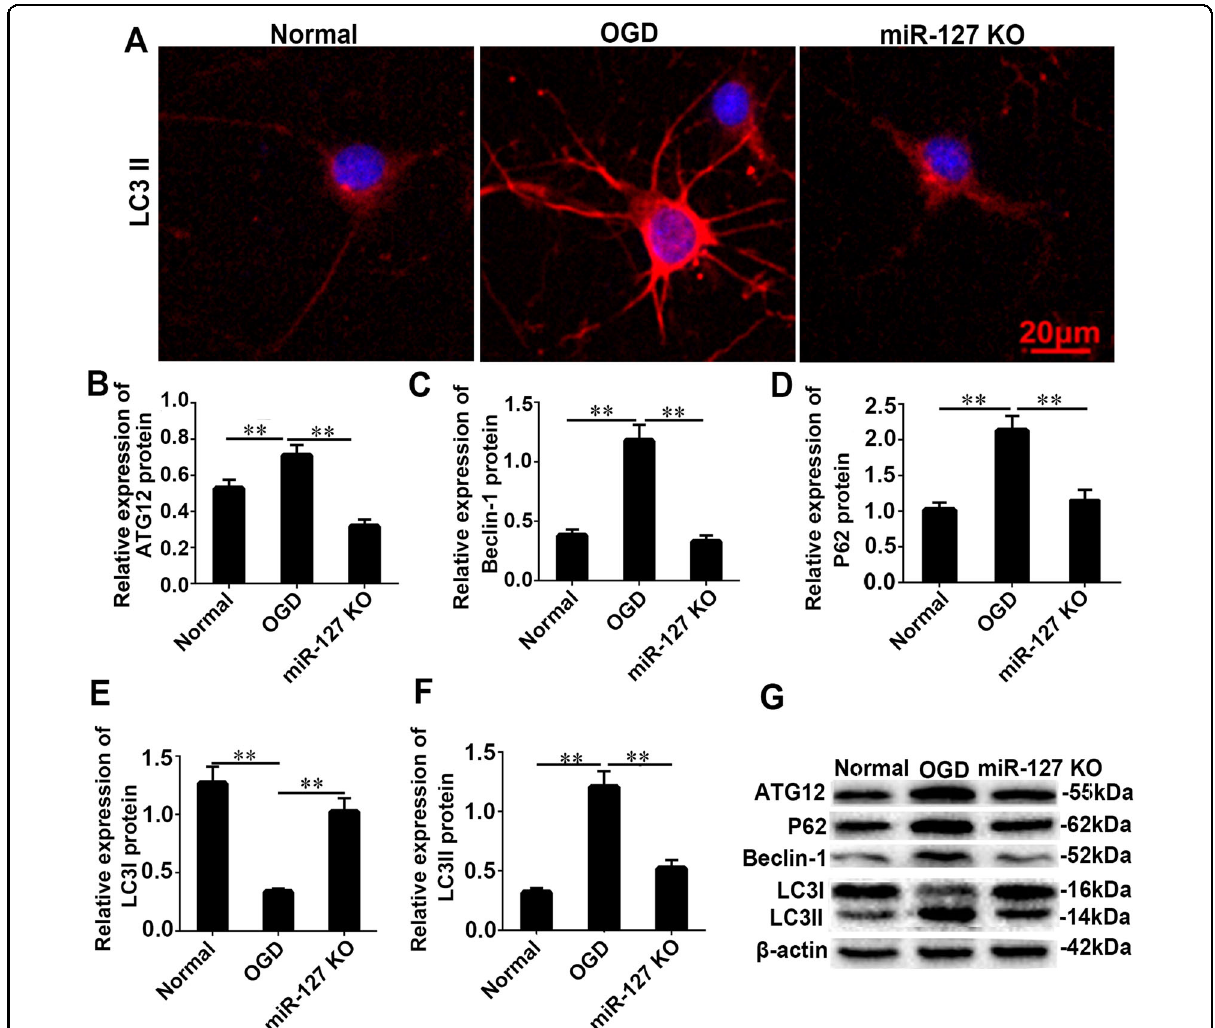
Fig. 4 KO-miR-127-3p relieved autophagy in vitro. A Autophagy of neurons was increased signi fi cantly in OGD, and reduced signi fi cantly in miR- 127-3p inhibitor. B , C – G The relative expression of ATG12, Beclin-1, P62, and LC 3II was obviously increased, and the relative expression of LC 3I was decreased signi fi cantly. However, the expression result of ATG12, Beclin-1, P62, LC3I, and LC3II was opposite in the miR127 KO rat group. OGD oxygen glucose deprivation, KO knock out. Scale bar = 20 μ m. The data are presented as the means ± s.d. ** P < 0.01 with one-way ANOVA, n =